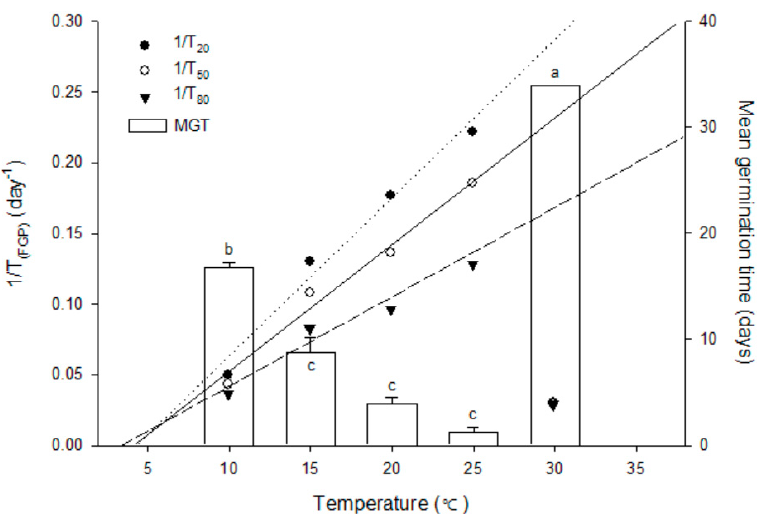
Figure 3. Effect of constant temperature regimes (5 ◦ C, 10 ◦ C, 15 ◦ C, 20 ◦ C, 25 ◦ C, 30 ◦ C, and 35 ◦ C) on the inverse of the time required to reach the FGP (1/T (FGP) ) and mean germination time, revealing linear relationships between 1/T (FGP) and temperature in the sub-optimal range. The dotted line, solid line, and short dashed line indicate the linear regression for 1/T 20 , 1/T 50 , and 1/T 80 , respectively, passing through the base temperature (T b ). The T b values were 4.56 ◦ C, 4.68 ◦ C, and 2.69 ◦ C for 1/T 20 , 1/T 50 , and 1/T 80 , respectively. Vertical bars indicate standard errors ( n = 4). Same lowercase letters indicate no significant difference ( p < 0.001).